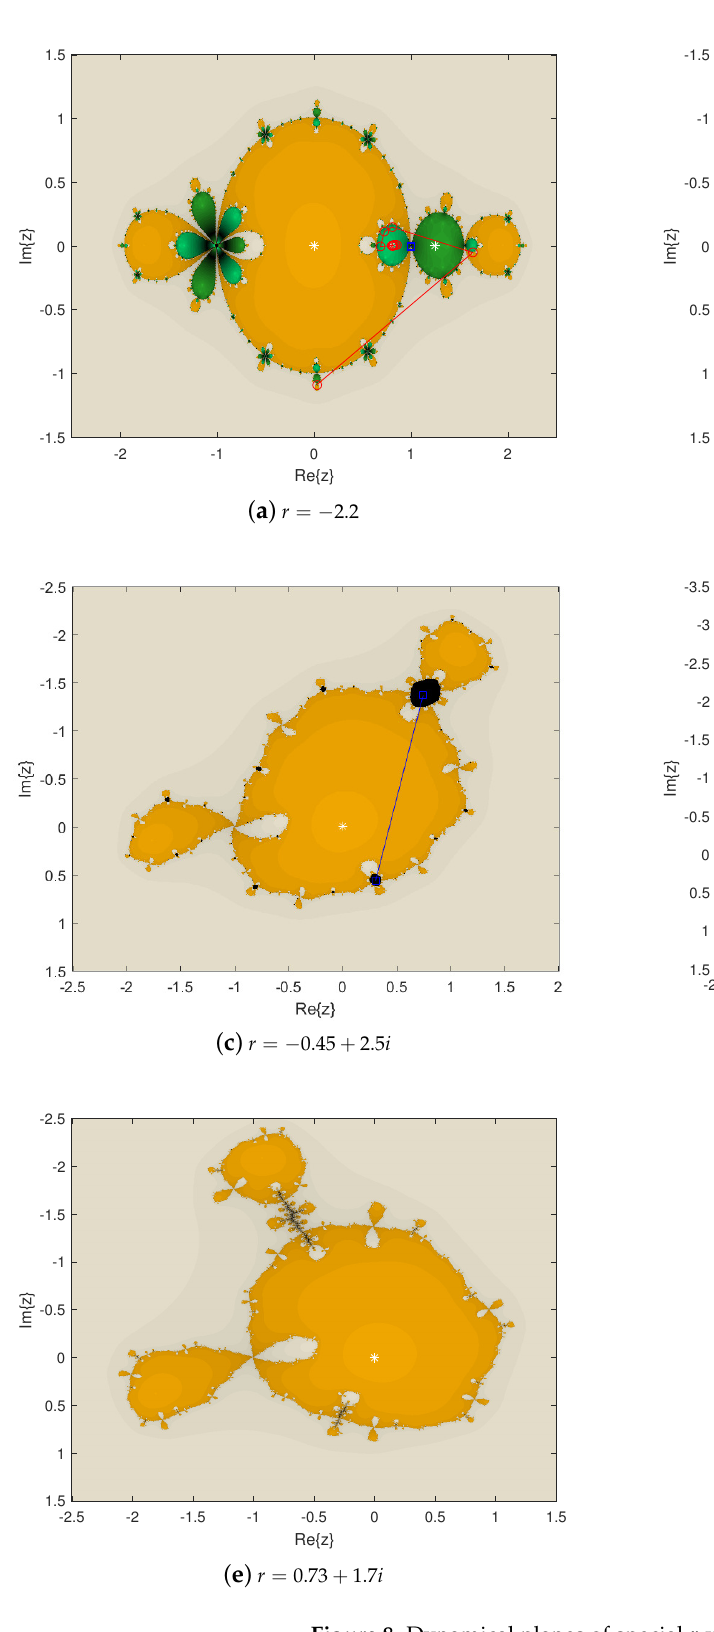
Figure 8. Dynamical planes of special r